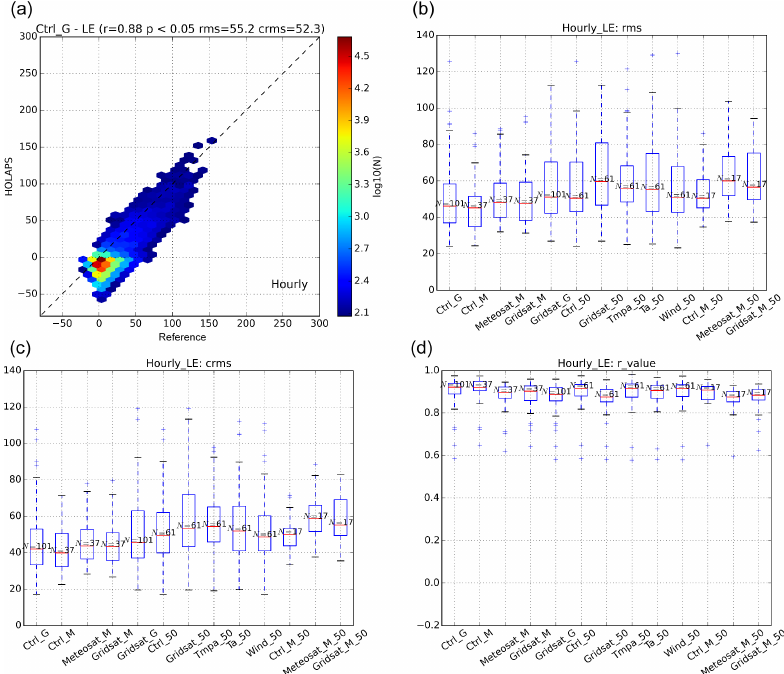
Figure E5. Error statistics for HOLAPS latent heat flux over clear-sky condition: (a) comparison using results from all stations and years, (b – d) box plots of validation statistics that are calculated at each